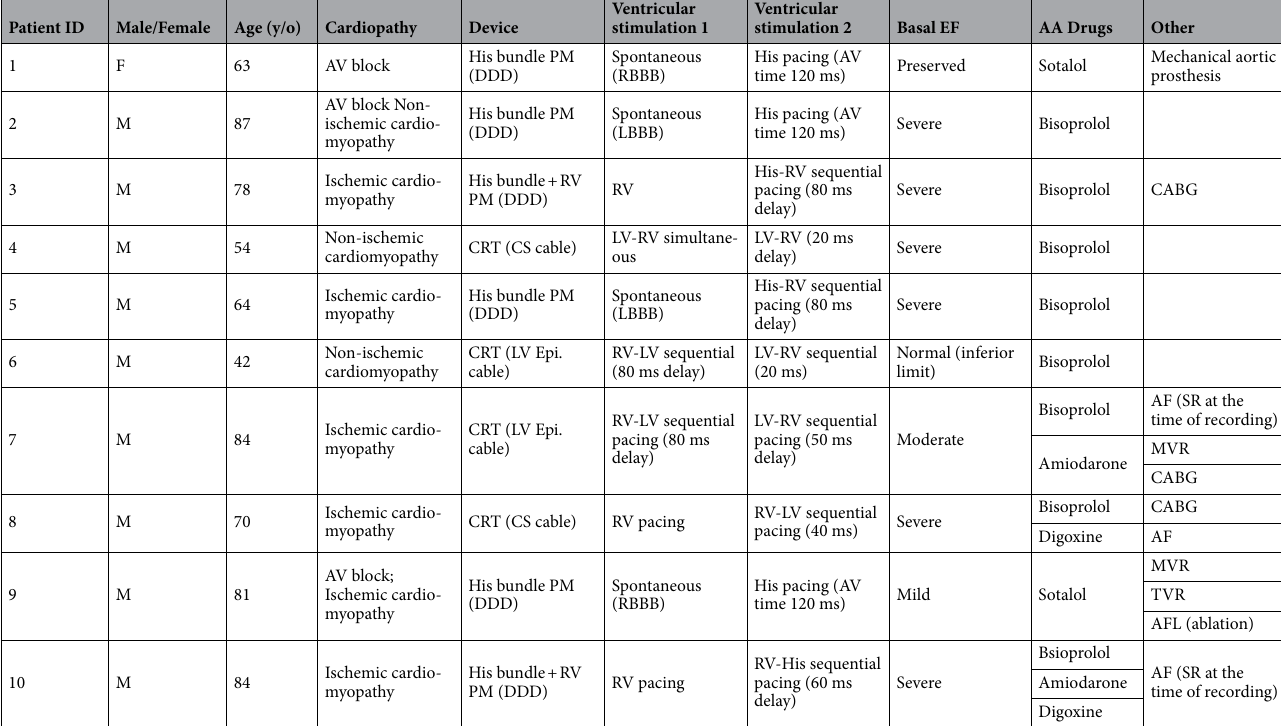
Table 1. Patients’ clinical data. AA antiarrhythmic, AF atrial fibrillation, AFL atrial flutter, AV atrioventricular, CABG coronary artery bypass graft, CRT cardiac resynchronization therapy, CS coronary sinus, DDD refers to the pacing configuration in which there is as dual pacing, sensing, and inhibition, EF ejection fraction, categorized according to guidelines 19 , Epi epicardial, LV left ventricle, LBBB left bundle branch block,